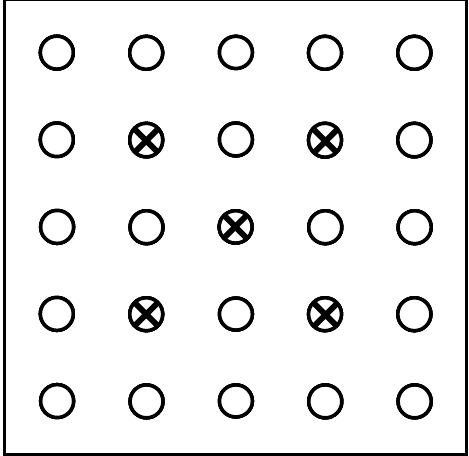
Figure 3. Indicative sampling positions for fisheye photography (crosses) and cover images (circles) in the sample plots. Cover images are spaced 10 m apart but sample outside the 40 m × 40 m, effectively sampling an area of 50 m × 50 m, represented by the square